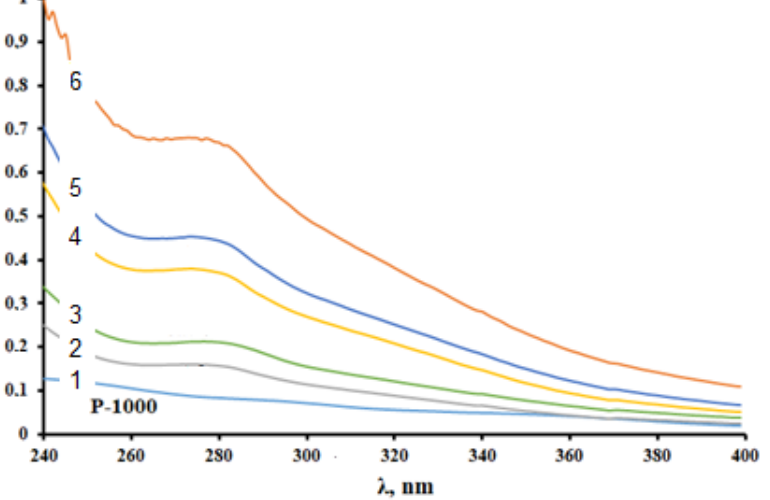
Figure 2. UV absorption spectra for (1) the initial WSSL, (2) Sulf. WSSL (Sib-ox-500g), (3) Sulf. WSSL (Sulf. Sibunit), (4) Sulf. WSSL (Sib-ox-400), (5) Sulf. WSSL (TiO 2 ), and (6) Sulf. WSSL (Al 2 O 3 ) lignin samples.